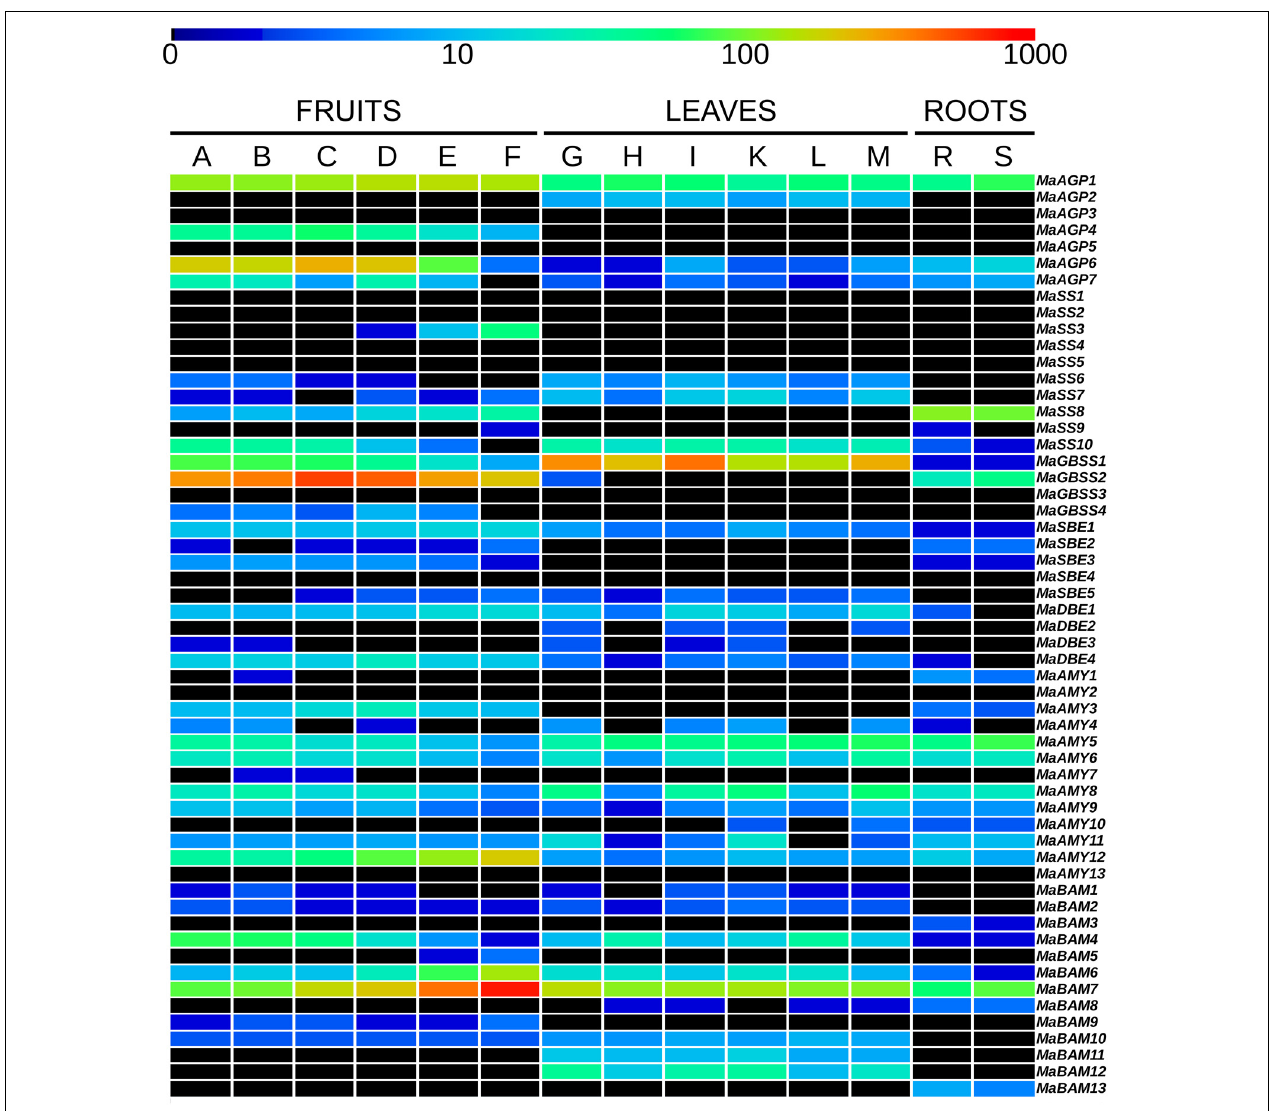
FIGURE 2 | Expression profiles of starch metabolism genes in banana tissues. Heatmap visualization of expression levels from published RNA-Seq data (D’Hont et al., 2012). The first six columns correspond to six libraries from Cavendish banana fruits harvested at 40, 60, and 90 days after flowering and stored for 5 days at 20 ◦ C without treatment (A, B, C, respectively) or harvested at 40, 60, and 90 days after flowering, treated for 24 h with acetylene and stored for 4 days at 20 ◦ C (D, E, F, respectively). The following six columns correspond to six libraries from leaf pieces of banana accessions Pisang Pipit, DH-Pahang and Pisang madu with mock inoculation (G, H, I, respectively) or inoculated with Mycosphaerella fijiensis (K, L, M respectively). The last two columns correspond to two libraries from accession Pahang banana roots inoculated with Fusarium oxysporum fsp cubense (R) or with mock inoculation (S). Transcript abundance was normalized in RPKM (reads per kilobase of exon per million mapped reads on banana gene models) and is indicated with a rainbow color logarithmic scale from dark blue (very weakly expressed) to red (1000 RPKM). Black boxes correspond to genes without detected expression (0